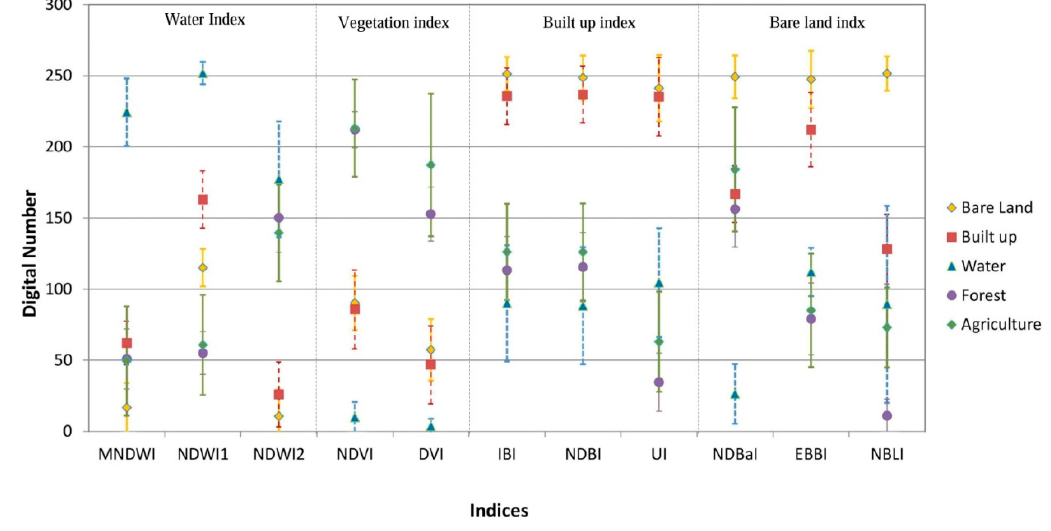
Figure 2. Statistics of samples of typical LULC types. All indices are grouped into four categories: Water index, Vegetation index, built-up index and Bare land index. All digital numbers were stretched into [0, 255]. Marks represent the average value of each type, while the bar in each direction indicates one standard deviation from the average.